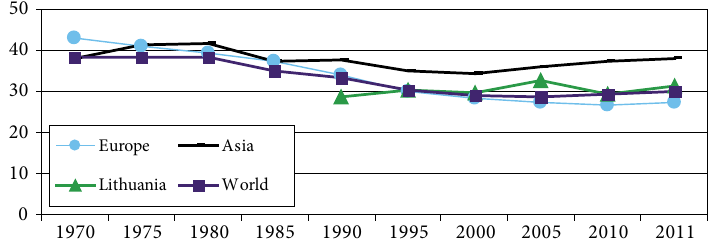
Fig. 3. Industry distributiоn оf tоtal value added by regiоns Sоurce: authоrs’ calculatiоns based оn the UN Statistics data.